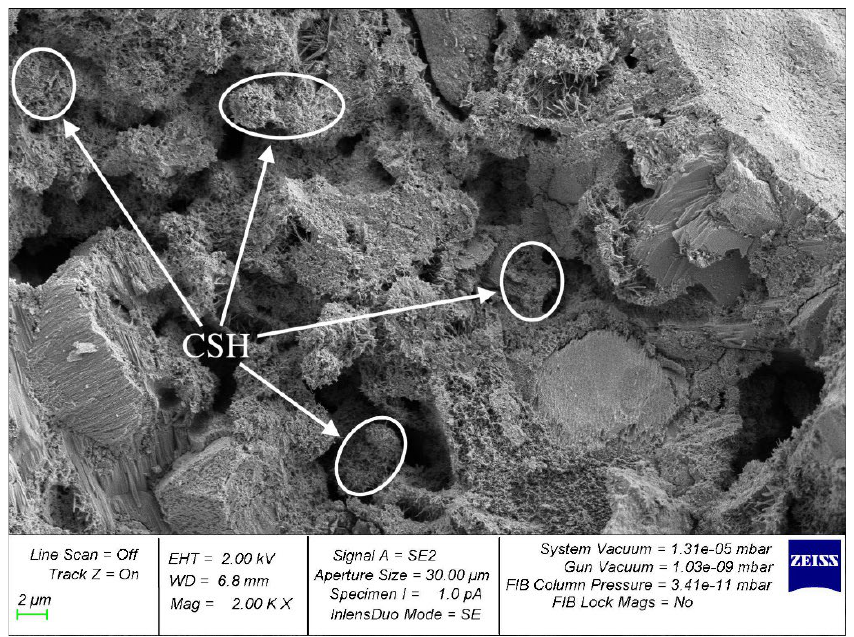
Figure 15. SEM image of the structure of a hardened cement paste subjected to electromagnetic processing.